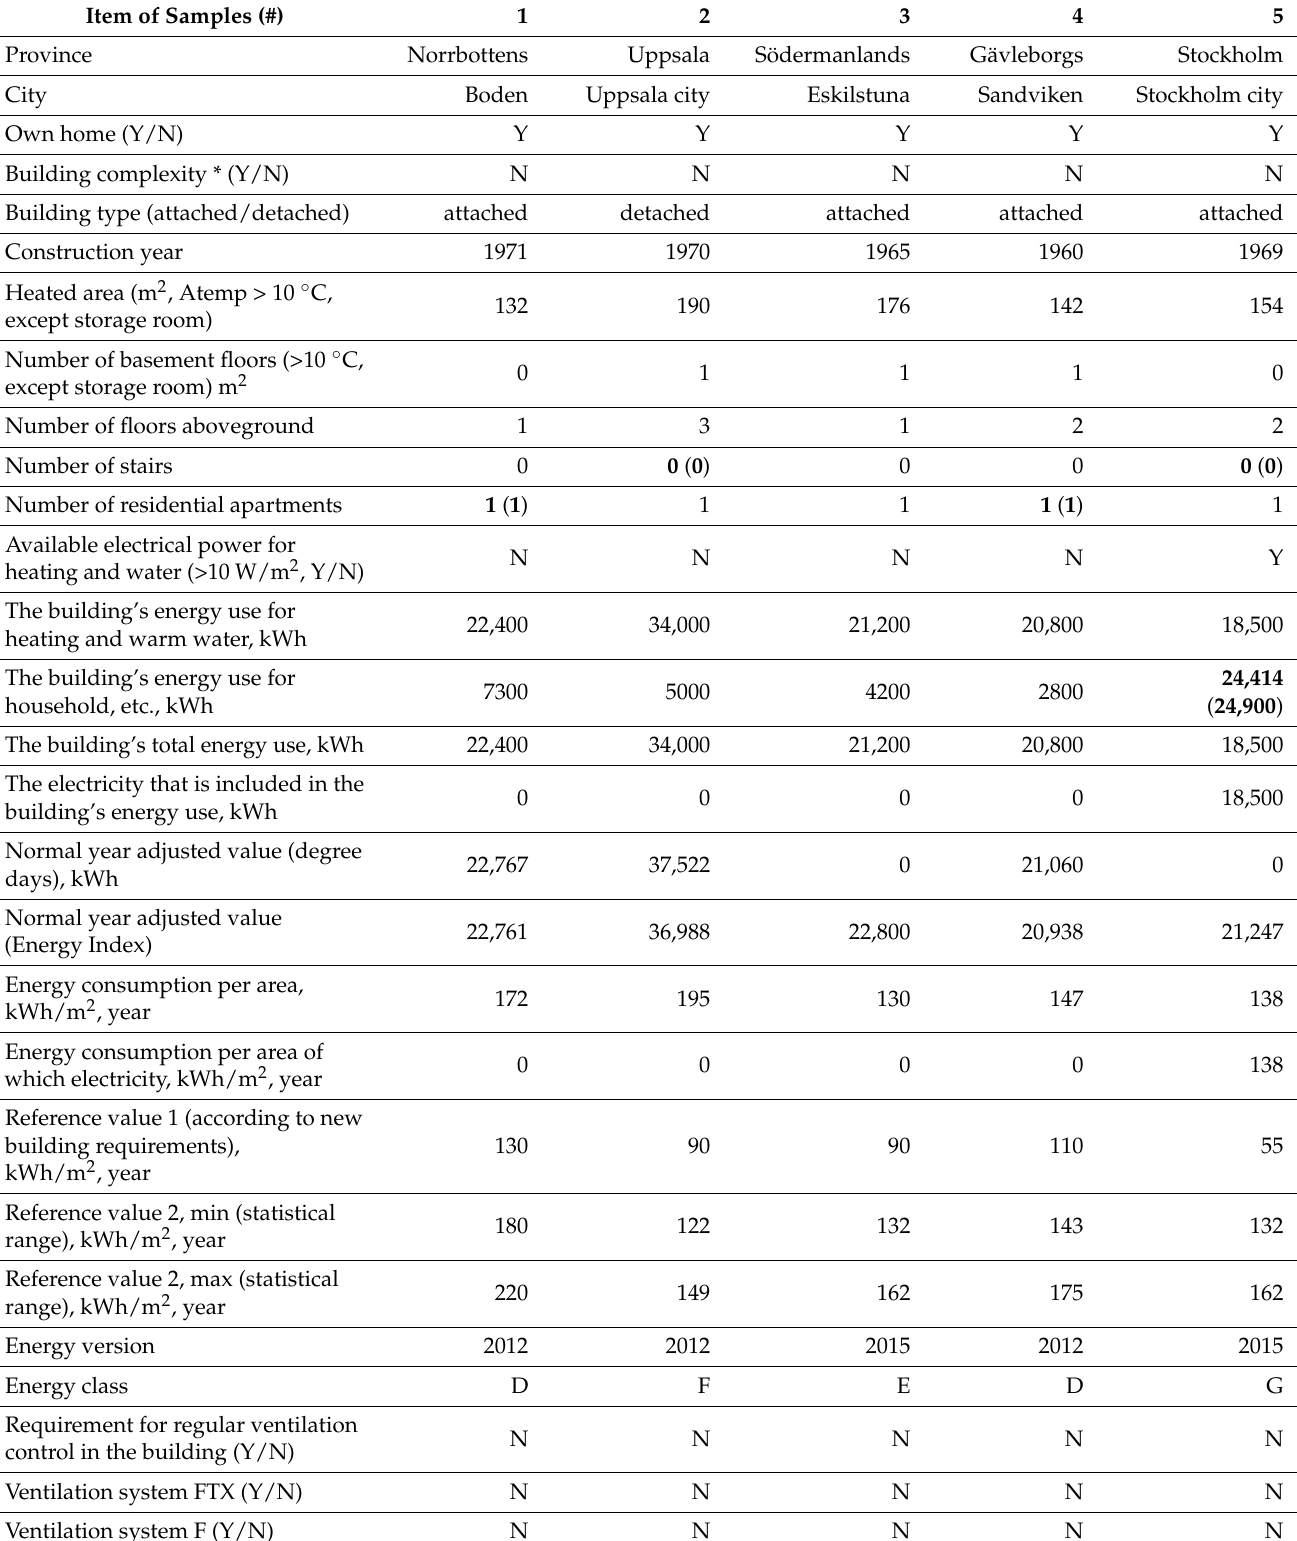
Table A1. The ten real individual building samples across Sweden and the results of missing data